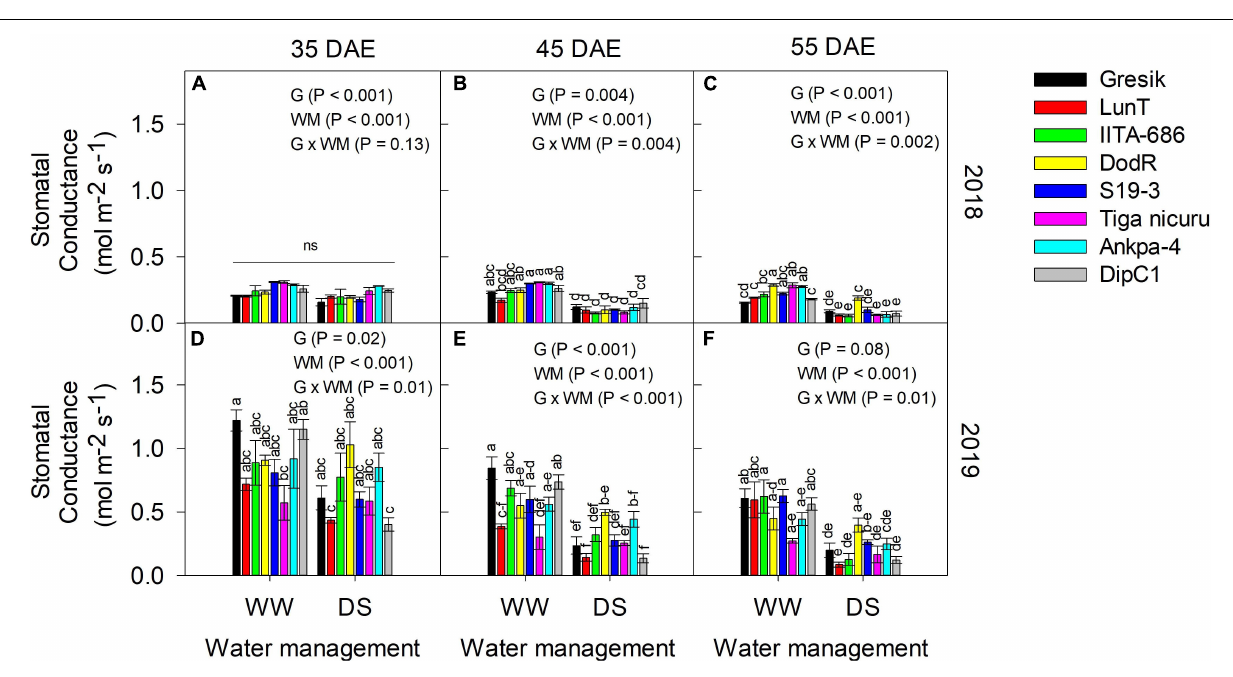
FIGURE 9 | Interaction effect Genotype (G) × Water management (WM) on stomatal conductance, g s (mol m − 2 s − 1 ) of eight bambara groundnut genotypes grown in soil-filled PVC columns under a rainout shelter at (A–C) 35, 45, and 55 DAE, respectively in 2018 and (D–F) 35, 45, and 55 DAE, respectively in 2019. The data is mean ± SE values ( n = 3), with different letters showing significant differences by Tukey’s honest significant difference post hoc test for treatment with ns, not